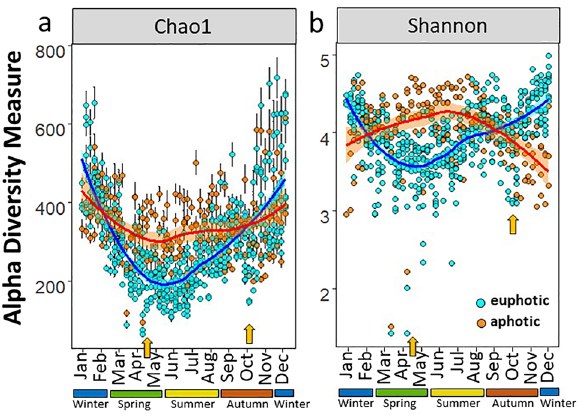
Figure 2. Seasonal trends for alpha diversity indices in the Bedford Basin from 2014 to 2017. Chao1 diversity ( a ; with standard errors as defined for the Chao1 model for estimating richness), and Shannon diversity ( b ). Orange arrows indicate low alpha diversity during the spring and autumn blooms. Samples from the euphotic (1, 5 and 10 m; cyan circles) and aphotic zone (60 m; orange circles) are colour coded. Loess regression lines are fitted for each zone and the inflection points on the regression lines show a minimum in April/May and in October for both